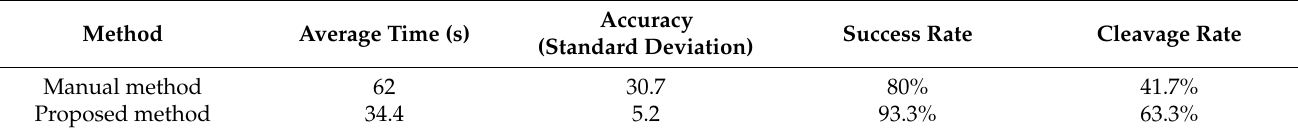
Table 1. Operation comparison between the manual and proposed enucleation methods.